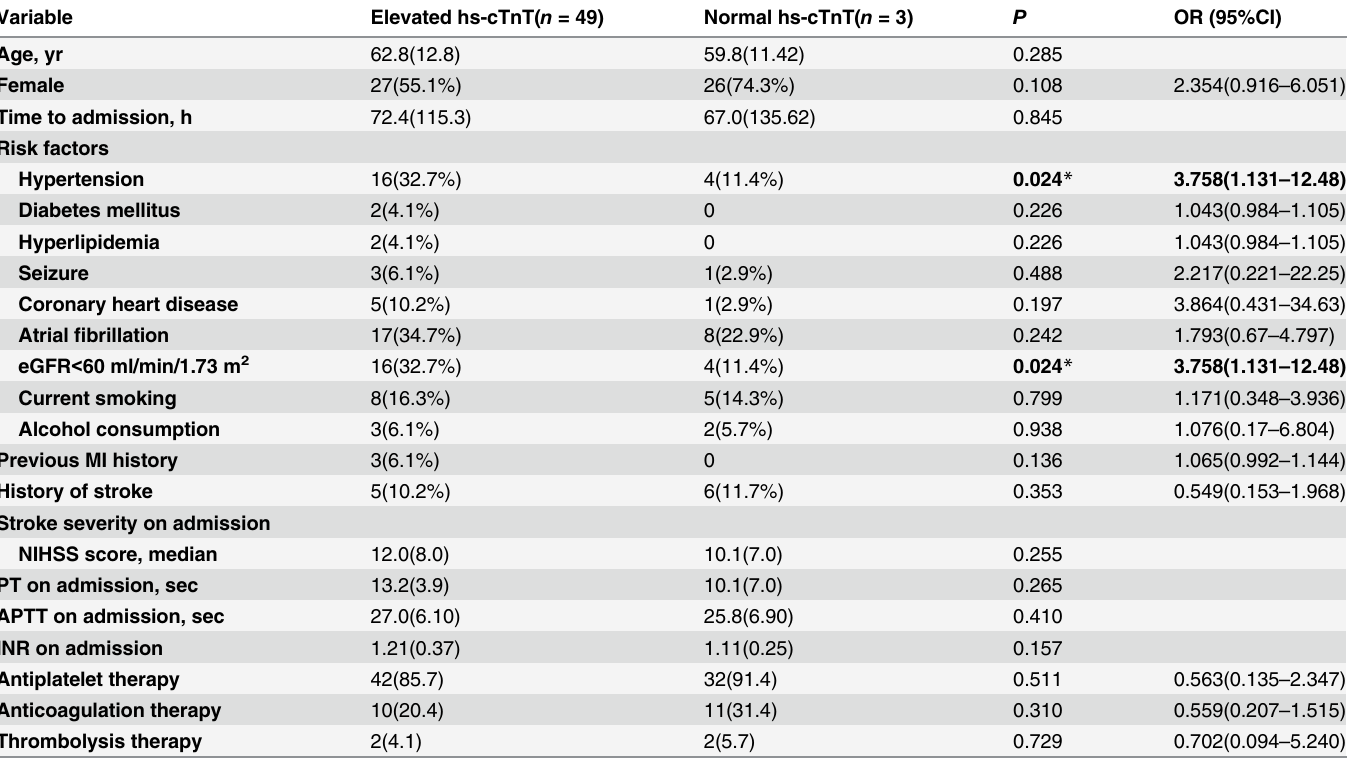
Table 2. Comparison of baseline characteristics between patients with elevated or normal hs-cTnT levels.